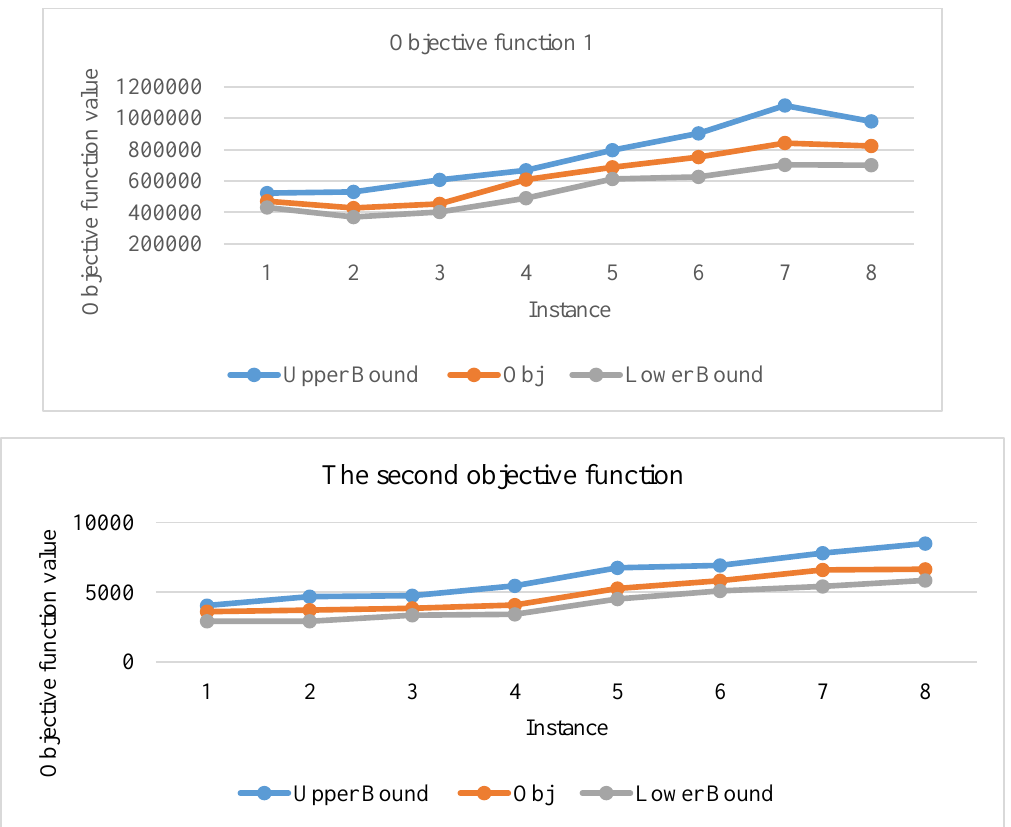
Figure 1. Changes in the first and the second objective functions over eight